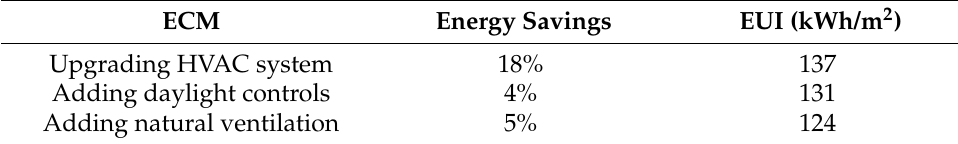
Table 1. Energy savings by implementing energy conservation measures (ECMs).